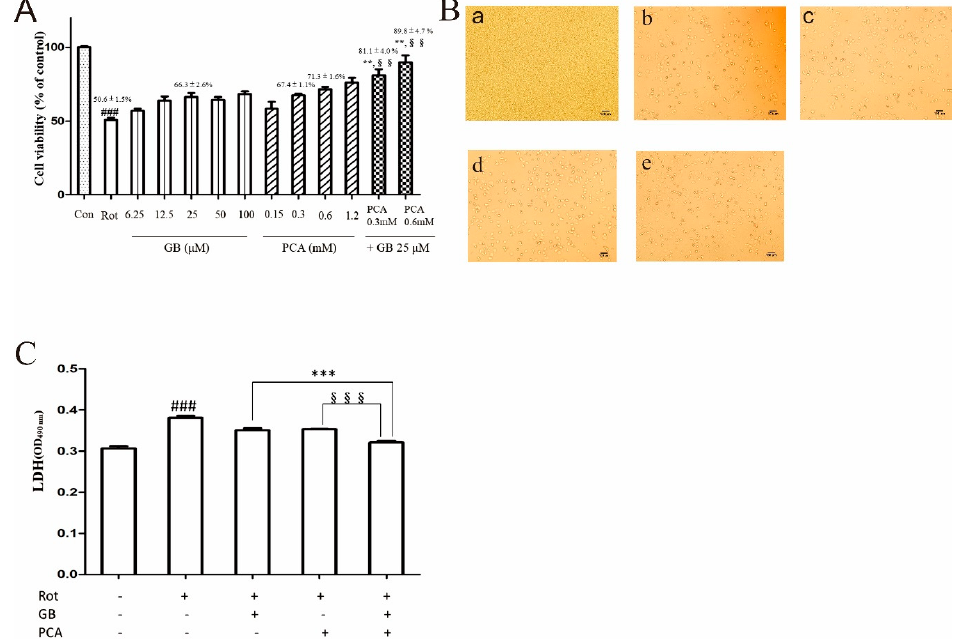
Figure 2. The effects of drugs on the cell viability and cytotoxicity of Rot-induced PC12 cells. ( A ) The effects of GB, PCA, and a combination of both drugs on the cell viability of Rot-induced PC12 cells. The cell viability of each treatment group was measured using an MTT assay. The data are means ± SDs. ( B ) The combined effect of GB and PCA on the morphology of Rot-induced PC12 cells (100×), a: control group; b: model group; c: GB (25 μ M)-treated group; d: PCA (0.6 mM)-treated group; e: combined treatment (GB-25 μ M, PCA-0.6 mM) group. ( C ) The combined effect of GB and PCA on LDH release in Rot-induced PC12 cells. The dates are expressed as the means ± SDs of the absorbance values. ### p < 0.001 vs. The control group. ** p < 0.01 and *** p < 0.001 vs. The GB-treated group at the same concentration. §§ p < 0.01 and §§§ p < 0.001 vs. The PCA-treated group at the same